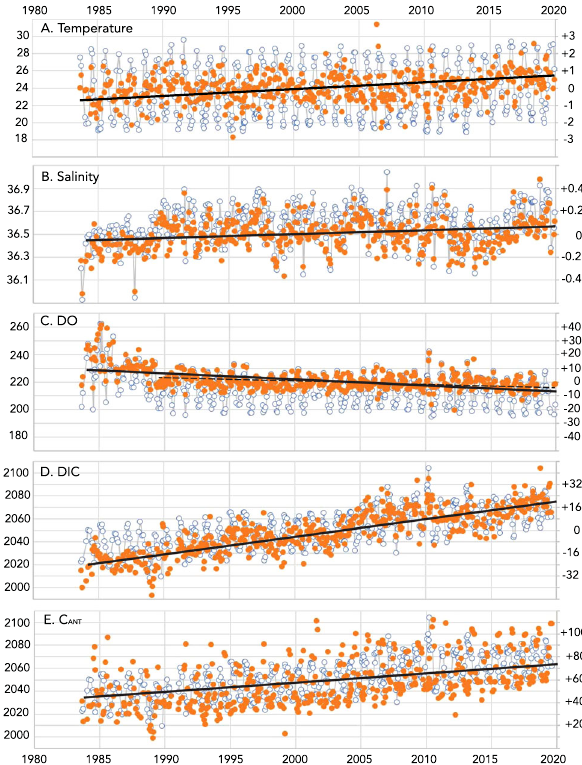
Fig. 1 Hydrographic and seawater CO 2 – carbonate properties at the BATS site (1988 – present) with earlier data (1983 – 1988) from Hydrostation S. Observed data (left vertical axis; open blue symbols) and anomalies (right vertical axis; orange symbols) are shown. Regression lines are from anomaly data plotted in the right vertical axis and given in Table 1. a Surface temperature and anomalies (°C). b Surface salinity and anomalies. c Surface dissolved oxygen (DO) and DO anomalies ( µ moles kg − 1 ); the dashed line shows the trend from 1990. d Surface DIC and salinity normalised DIC (nDIC; µ moleskg − 1 ). e nDIC and C ANT values ( µ moles kg − 1